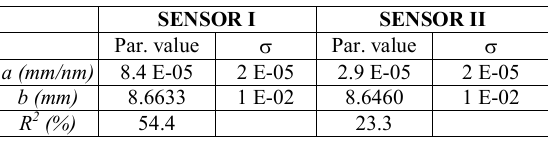
Table 4. Slope-intercept parameters and respective standard deviations of two straight lines modelling focal length variations for different bands of the two sensors and the R 2